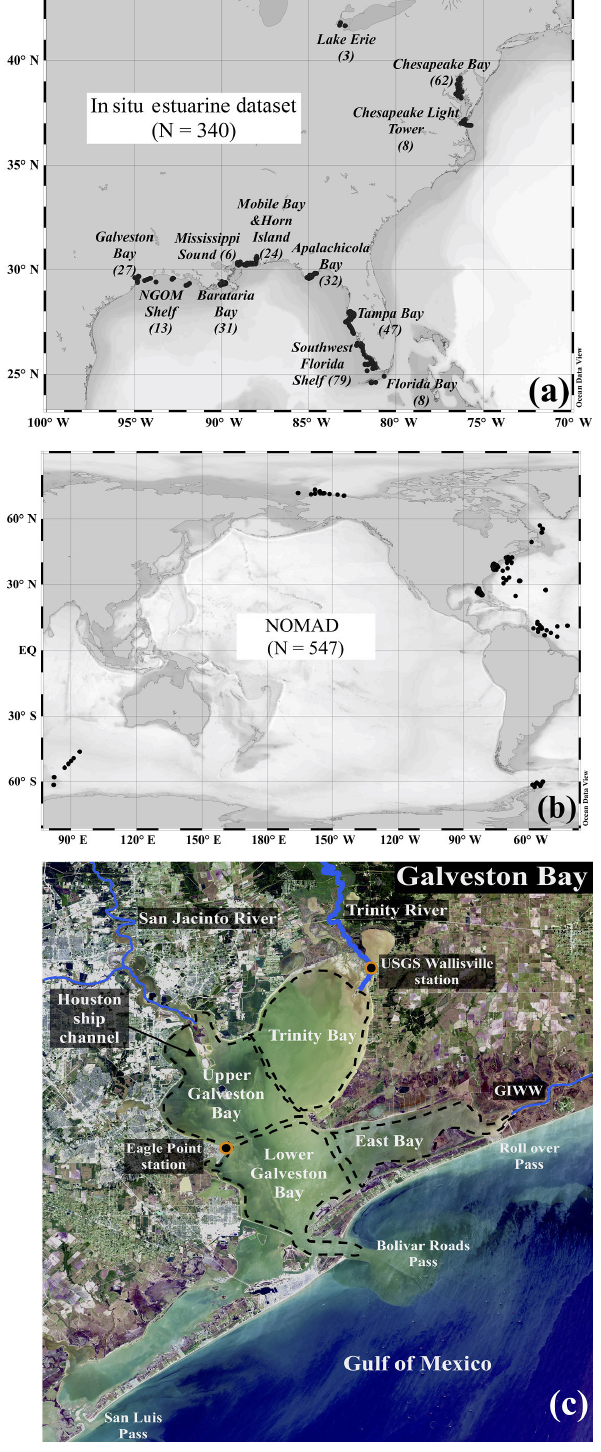
Figure 1. (a) In situ dataset (IES) representing estuarine and nearshore waters ( < 10m) on the US East Coast and in the northern Gulf of Mexico ( N = 340), (b) NOMAD ( N = 547), and (c) Galve- ston Bay, Texas (USA). GIWW: Gulf Intracoastal